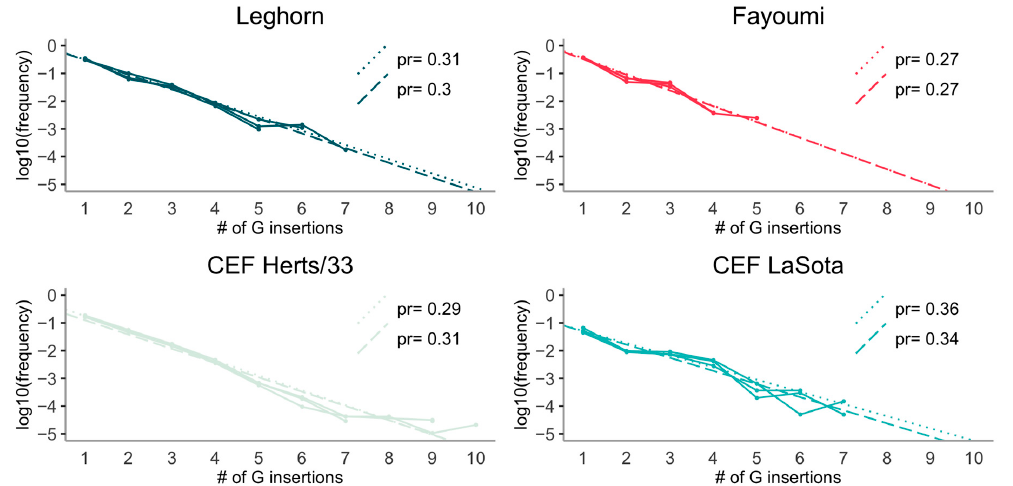
Figure 4. Log-plots of mRNA fraction as a function of insertion length, presented for each sample separately. Straight lines show the linear regressions for each experiment (the dotted line corresponds to the “Poisson-weighted” regression).